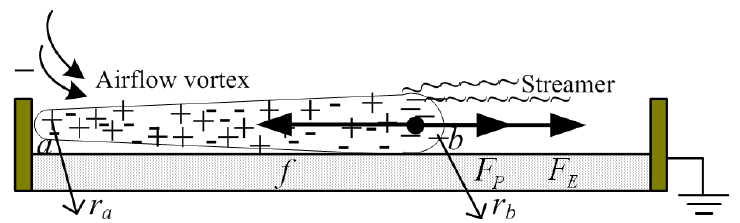
Figure 3. Schematic diagram of force analysis of